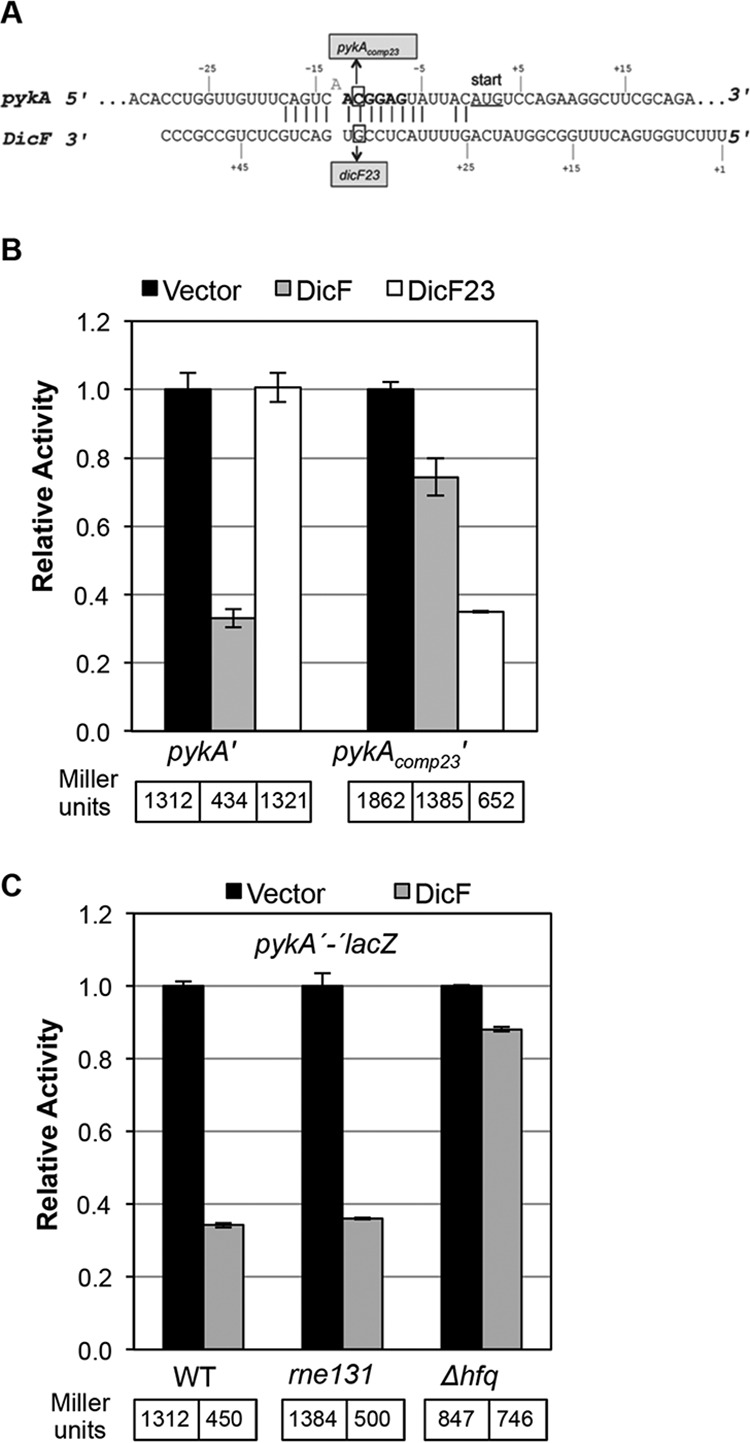
Genetic and molecular characterization of DicF-pykA mRNA interactions. (A) Base pairing predictions for pykA mRNA and DicF. The numbers for pykA are relative to the start codon (with A as +1). The numbers for DicF are relative to the 5′ end of dicF. The pykA RBS is shown in bold, and the start codon is underlined. The predicted base pairing interactions between pykA and DicF are marked by vertical lines, and mutations in dicF and pykA are indicated by boxes. All mutations were substitutions, and boxed residues were changed to the complementary nucleotides. (B) The levels of β-galactosidase activities of the pykA translational fusion were assayed during overexpression of DicF and DicF23. (C) The levels of β-galactosidase activity of the pykA′-′lacZ fusion in the wt strain and the rne131 and hfq mutants were assayed during overexpression of DicF. The specific activities of the fusions were normalized as described for Fig. 2.